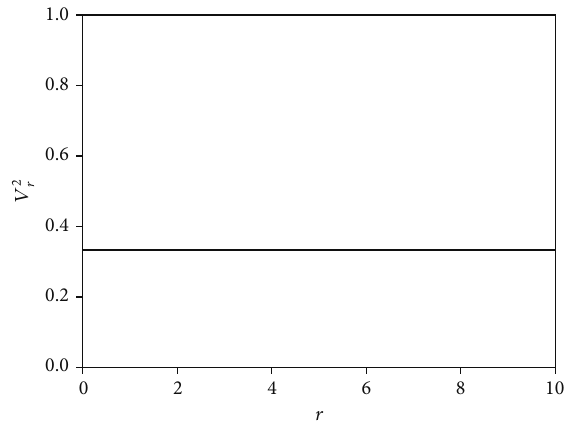
Figure 9: Speed of sound v against radial distance r .